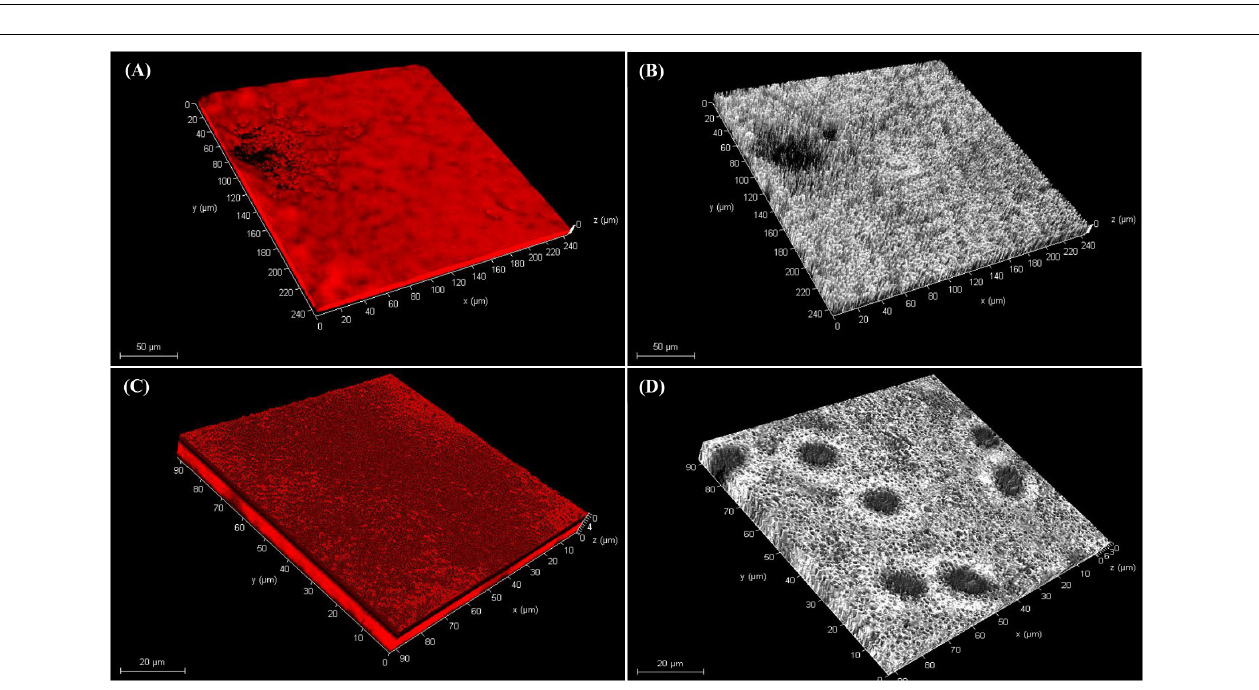
FIGURE 5 | Confocal laser scanning microscopy of biofilm. Three-dimensional (3D) views of (A,B) M45 and (C,D) K96 biofilms grown for 48 h. Bacteria were stained with acridine orange and observed by CLSM.